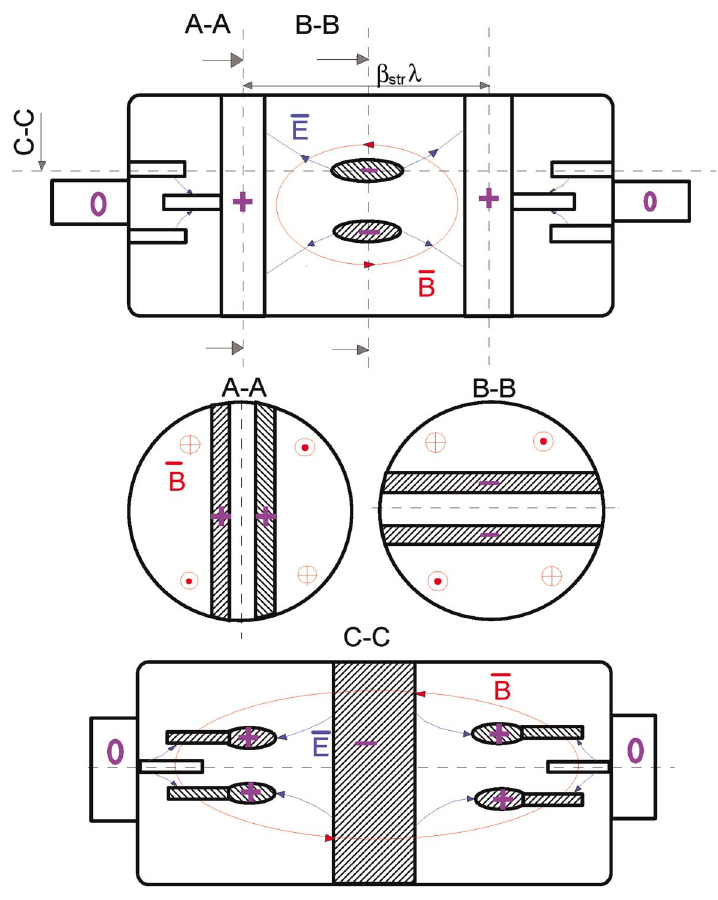
FIG. 8. (Color) Field picture in the slot-finger resonator.